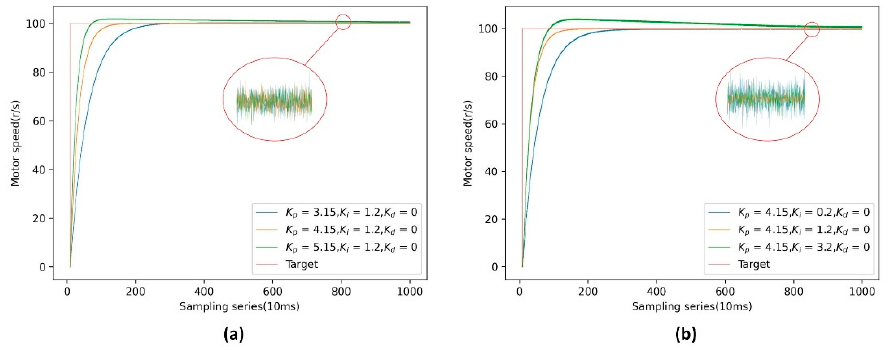
Figure 7. Data analysis curve of different PID parameters: ( a ) response curves under different K p conditions and ( b ) response curves under different K i conditions.